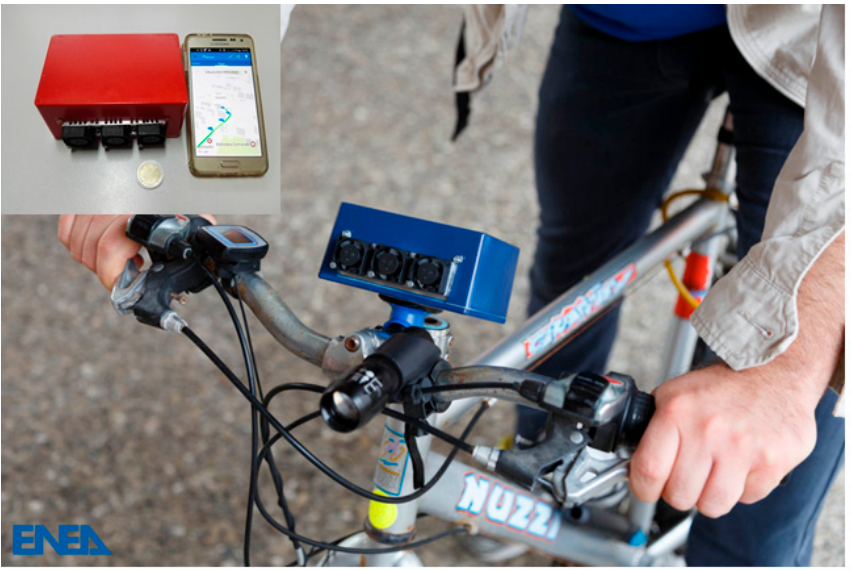
Figure 4. The Monica TM system is a solution for cooperative urban pollution monitoring [53]. It relies on an STM32 microprocessor and is equipped with an NO 2 , CO, RH, T and O 3 sensors. Data can be sent to a smartphone and shared with other users to construct a real-time pollution map of the city.